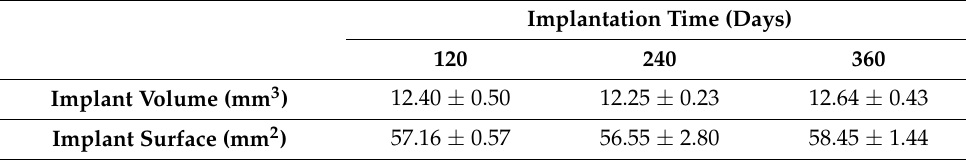
Table 2. Values of implant volume and surface in different time